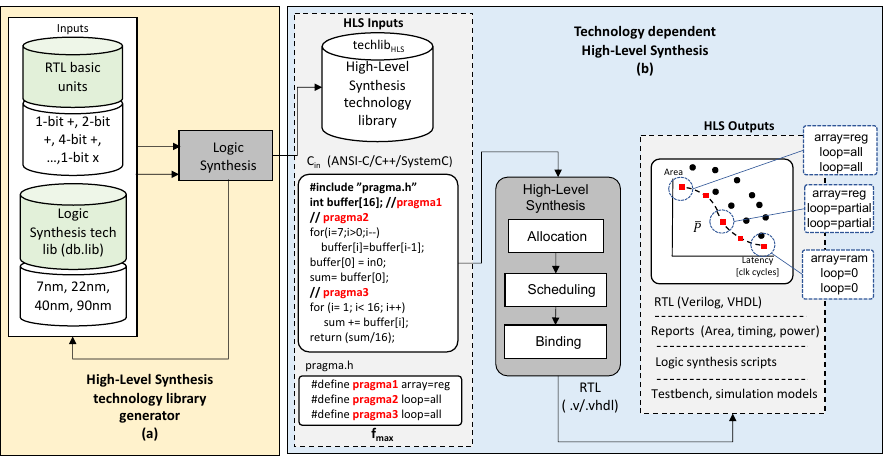
Figure 2. High-Level Synthesis (HLS) overview.